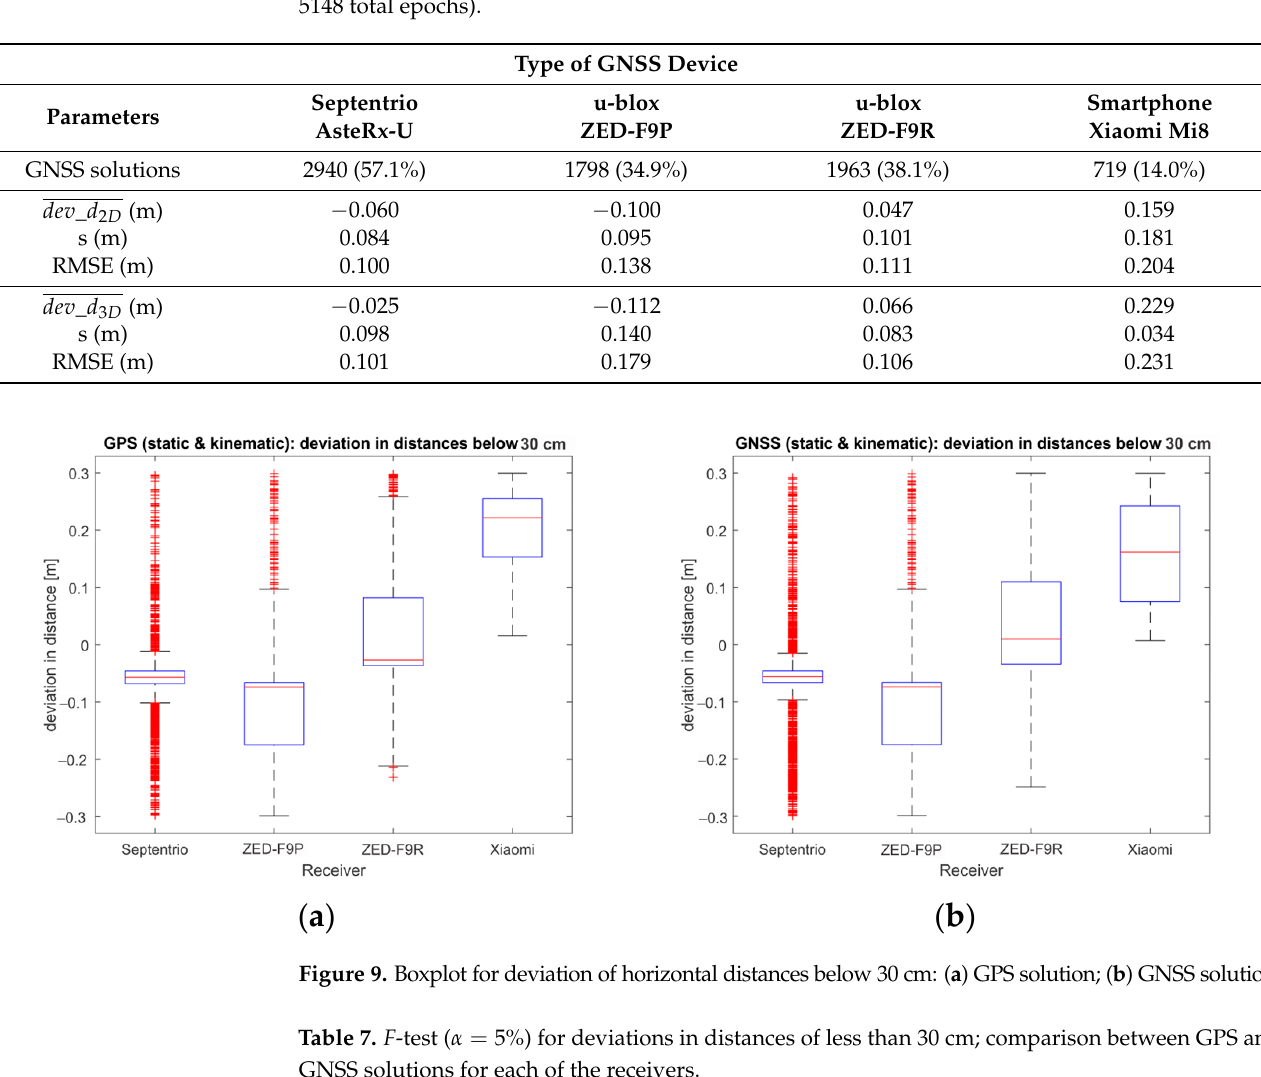
Table 6. Statistics (mean, standard deviation, and RMSE) for GNSS solutions for filtered values of deviation in distances that were below 30cm. Situation: entire trajectory (static and kinematic: 5148 total epochs).